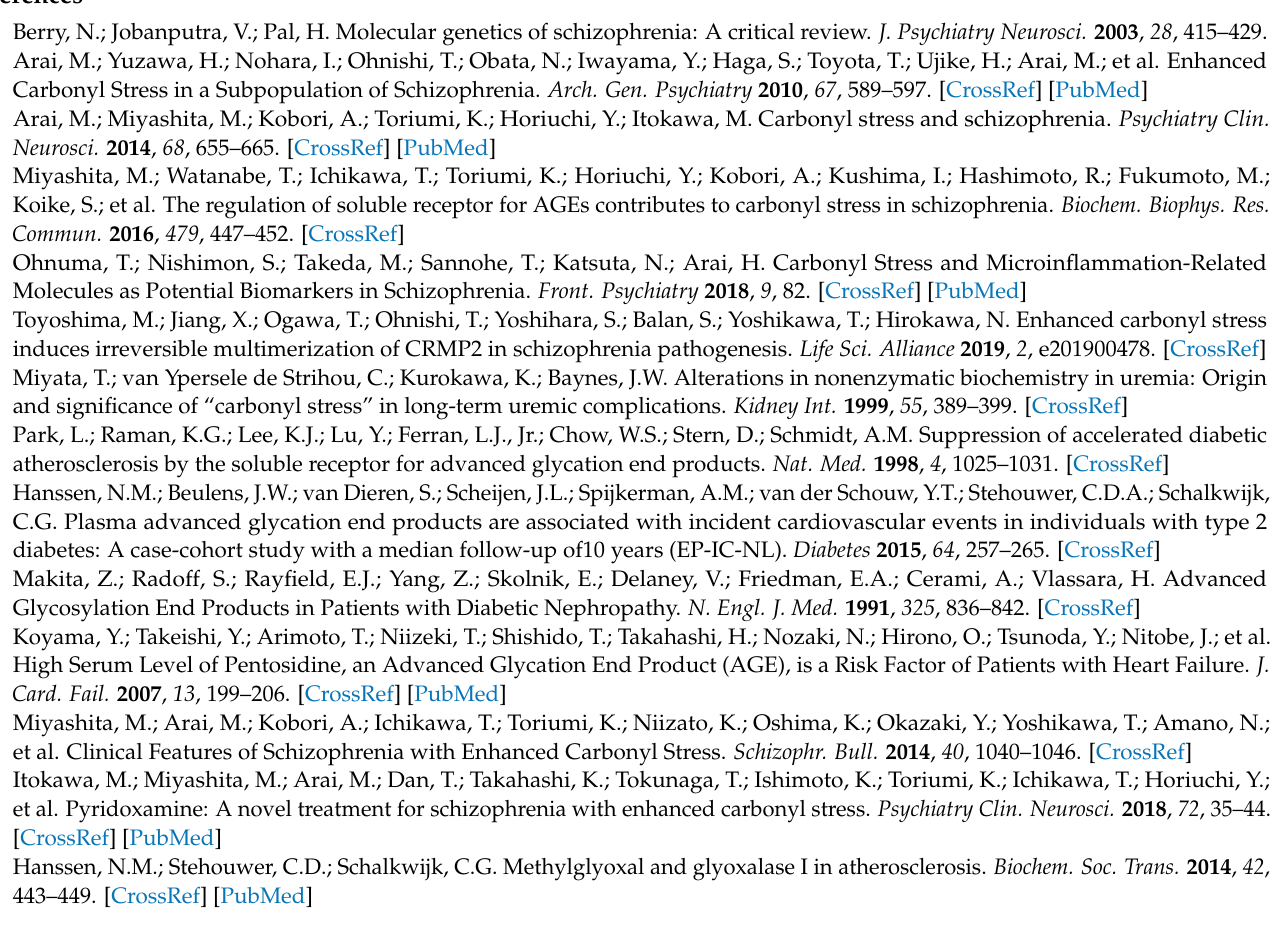
Figure S2: Detection of various carbonyl proteins modified by AGEs in various regions of mice